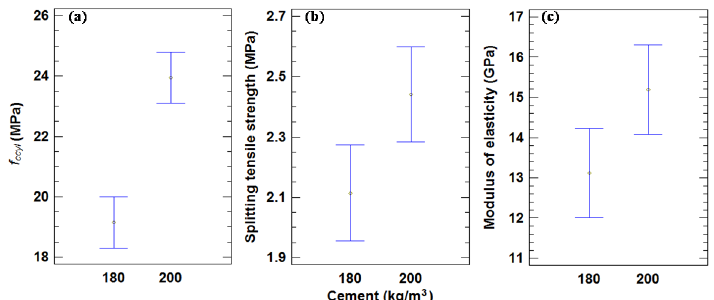
Figure 3. ( a ) Mean values of compressive strength in cylindrical specimens and 95% LSD intervals vs. amount of cement. ( b ) Mean values of splitting tensile strength and 95% LSD intervals vs. amount of cement. ( c ) Mean values of modulus of elasticity 95% LSD intervals vs. amount of cement.